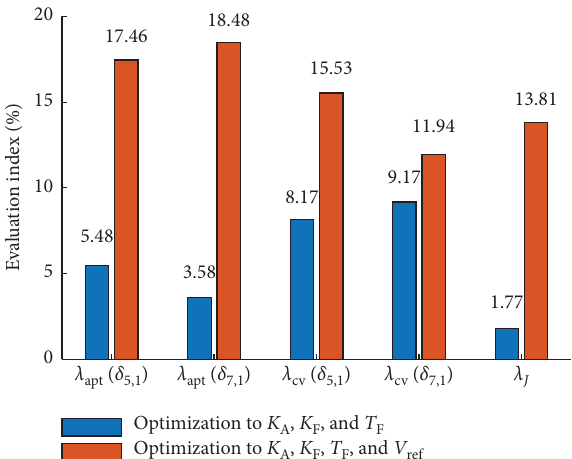
Figure 13: Comparison of optimization to K A , K F , and T F and optimization to K A , K F , T F , and V ref .